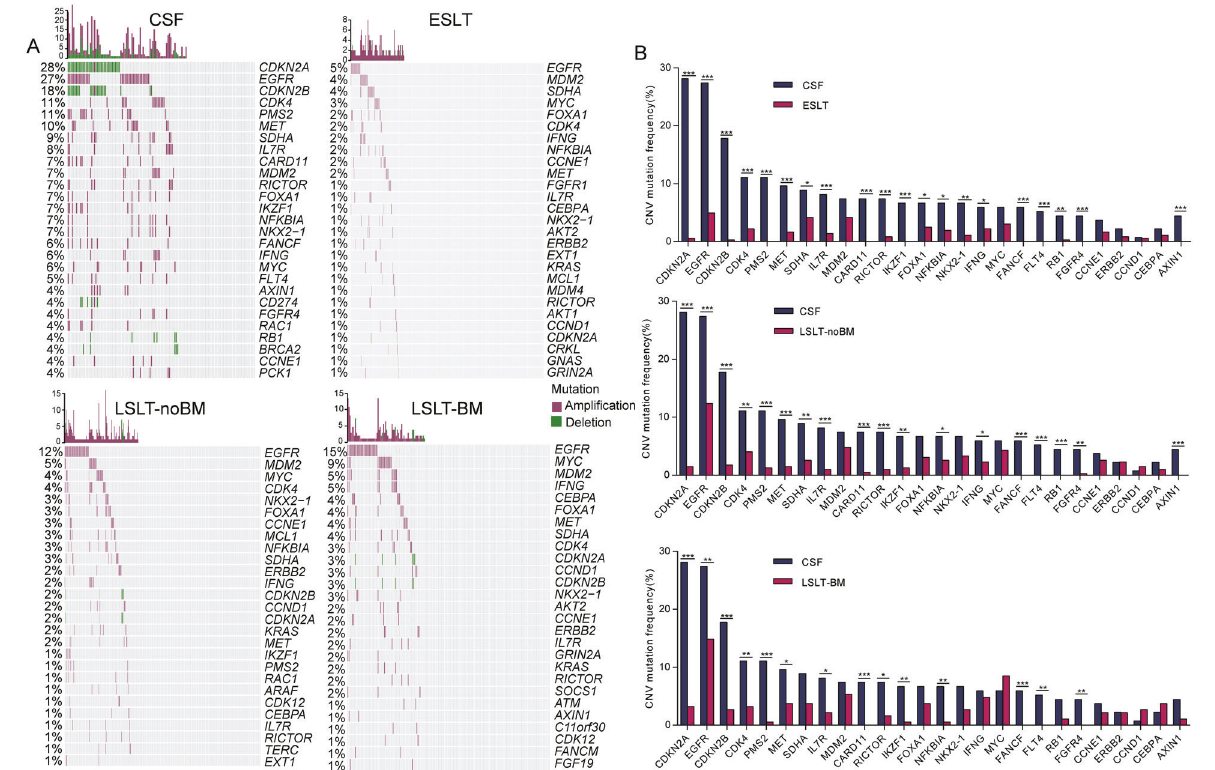
Fig. 4 CNVs analysis of LUAD patients at different stages. A High frequently mutated genes in CSF and primary lung tumors are shown. Mutation frequencies in the group are shown on the left. CNV counts (number of CNV events) for each patient is shown at the top. B Comparison of mutation frequencies of CNV genes between CSF and the other three groups, respectively. Signi fi cantly different genes were calculated by two-sided Fisher ’ s exact test. * P < 0.05, ** P < 0.01, *** P <